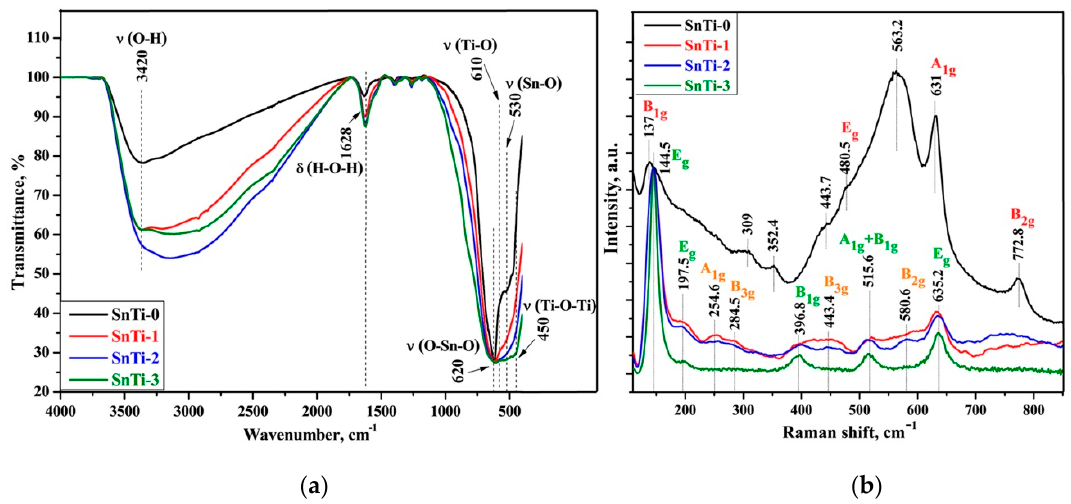
Figure 5. ( a ) FT-IR spectra of nanocrystalline SnO 2 and TiO 2 @SnO 2 composites normalized to the intensity of (O–Sn–O) oscillations; ( b ) Normalized Raman spectra of nanocrystalline SnO 2 and TiO 2 @SnO 2 composites.